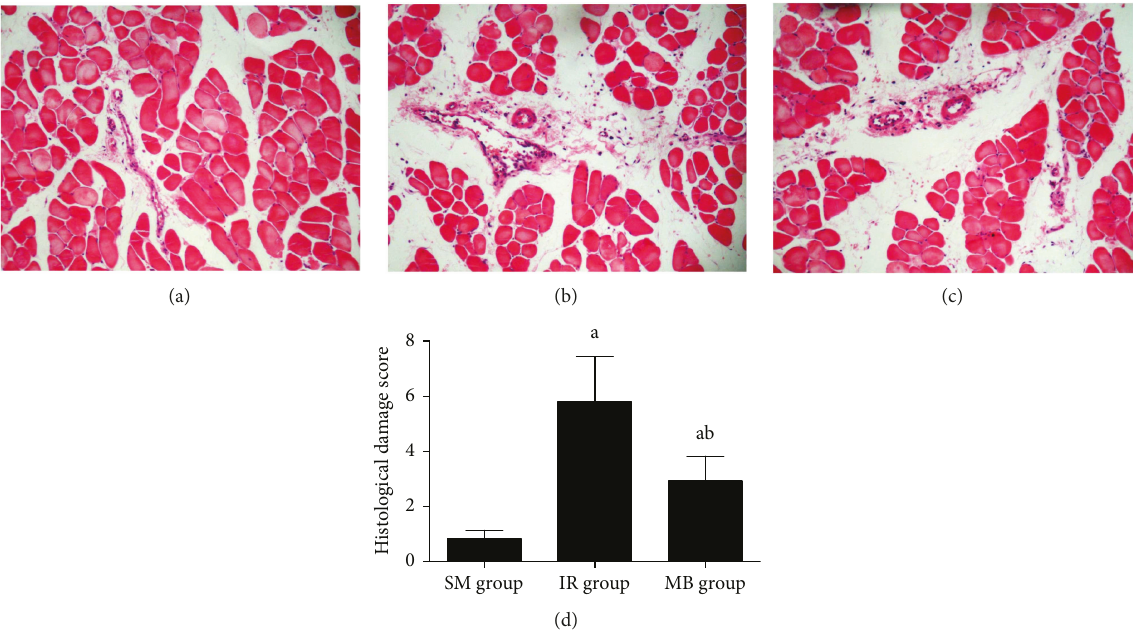
Figure 1: Histological changes in muscle tissue. (a) SM group; (b) IR group; (c) MB group; (d) histological damage score in muscle tissue. a p < 0 05 versus SM group; b p < 0 05 versus IR